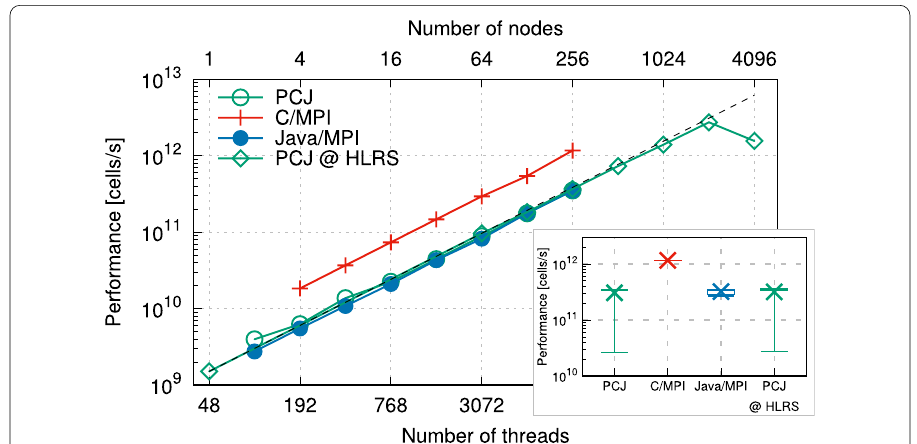
Fig. 5 Performance results of Game of Life implemented with PCJ, C/MPI and Java/MPI for 604,800 × 604,800 cells universe. The strong scaling results were obtained on Cray XC40 at ICM (PCJ, C/MPI and Java/MPI) and Cray XC40 at HLRS (PCJ). Ideal scaling for PCJ is drawn (dashed line). Inset plot presents the performance statistics calculated based on 11 time steps on 256 nodes (12,288 threads). In the inset plot, ends of whiskers are minimum and maximum values, a cross ( × ) represents an average value, a box represents values between 1st and 3rd quartiles, and a band inside the box is a median